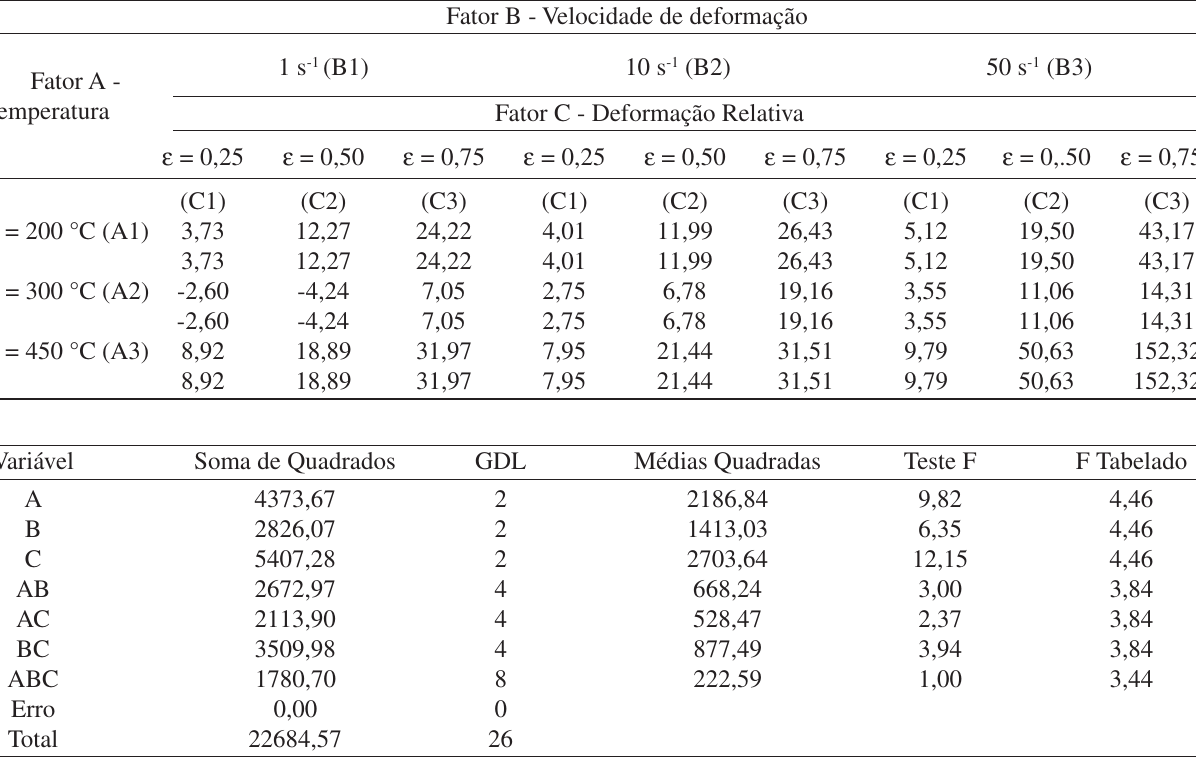
Tabela 1. Dados e tabela ANOVA para o lubrificante “Deltaforge 31”. Fator B - Velocidade de deformação